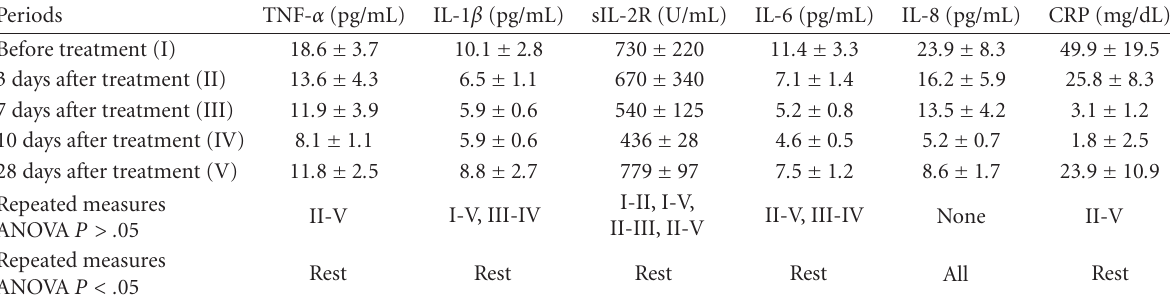
Table 2. Serum cytokines and CRP levels (mean ± SD) in di ff erent periods after VAD treatment.